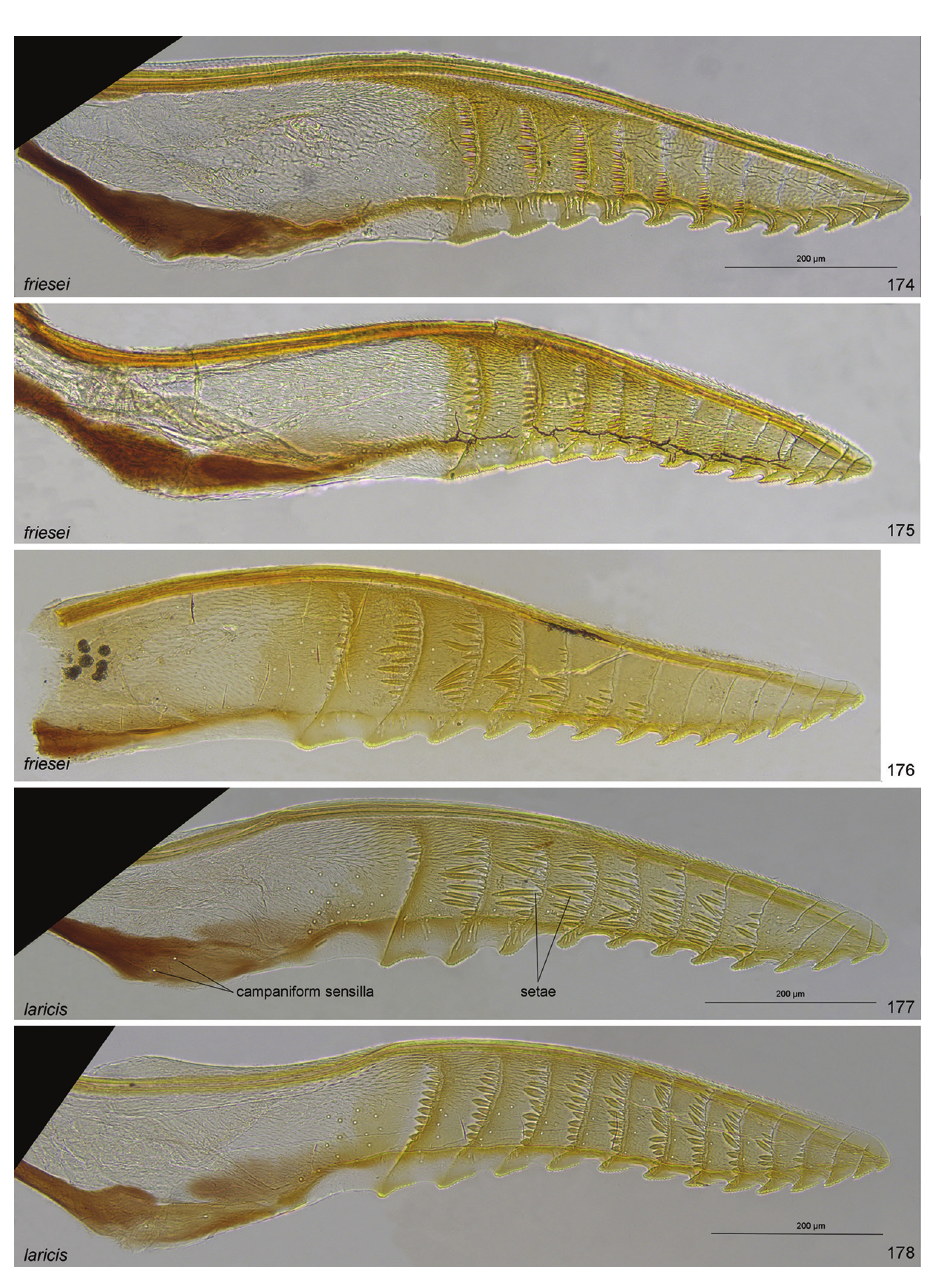
Figures 174–178. Lancets of Pristiphora . 174 friesei DEI-GISHym11557 175 friesei , holotype of atrata 176 friesei lectotype 177 laricis PR.207VV 178 laricis